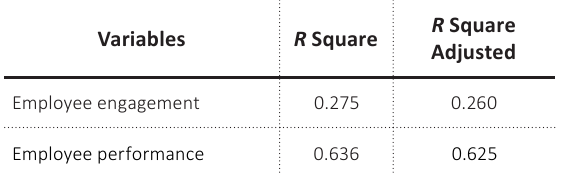
Table 6. R -square